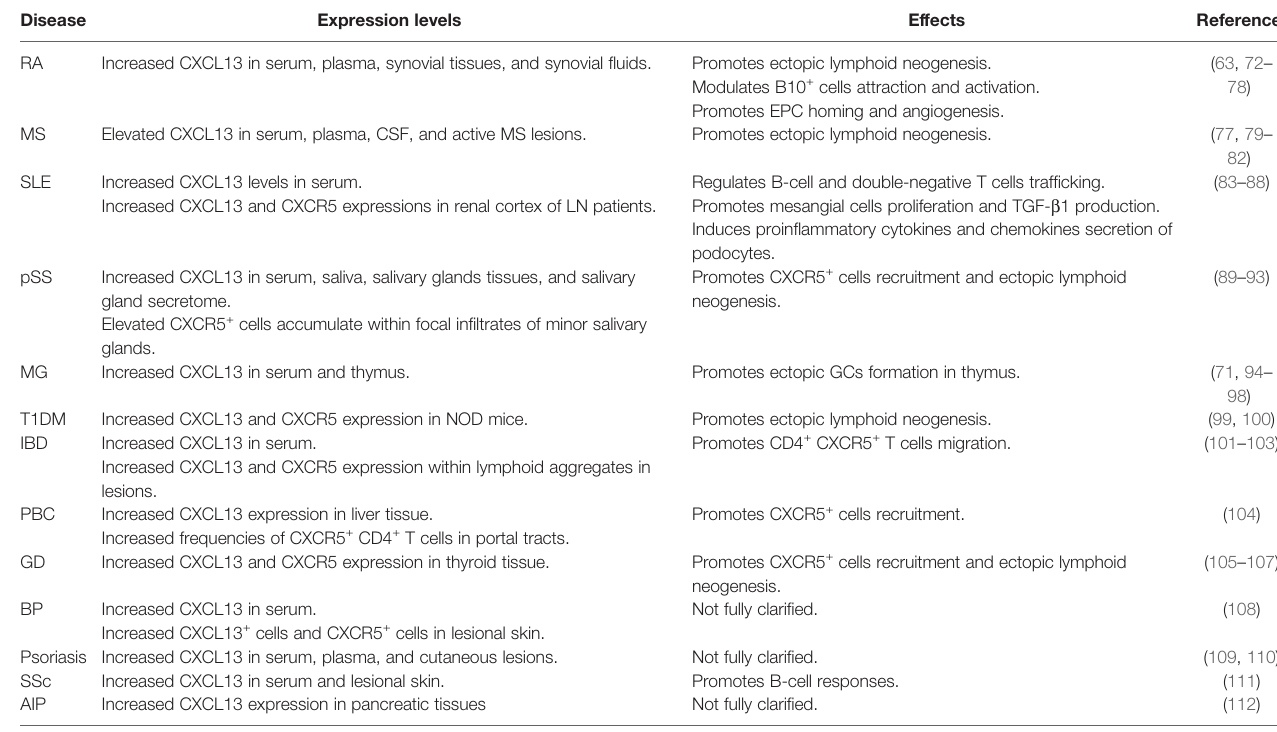
TABLE 1 | Expression levels and effects of CXCL13/CXCR5 axis in autoimmune diseases.